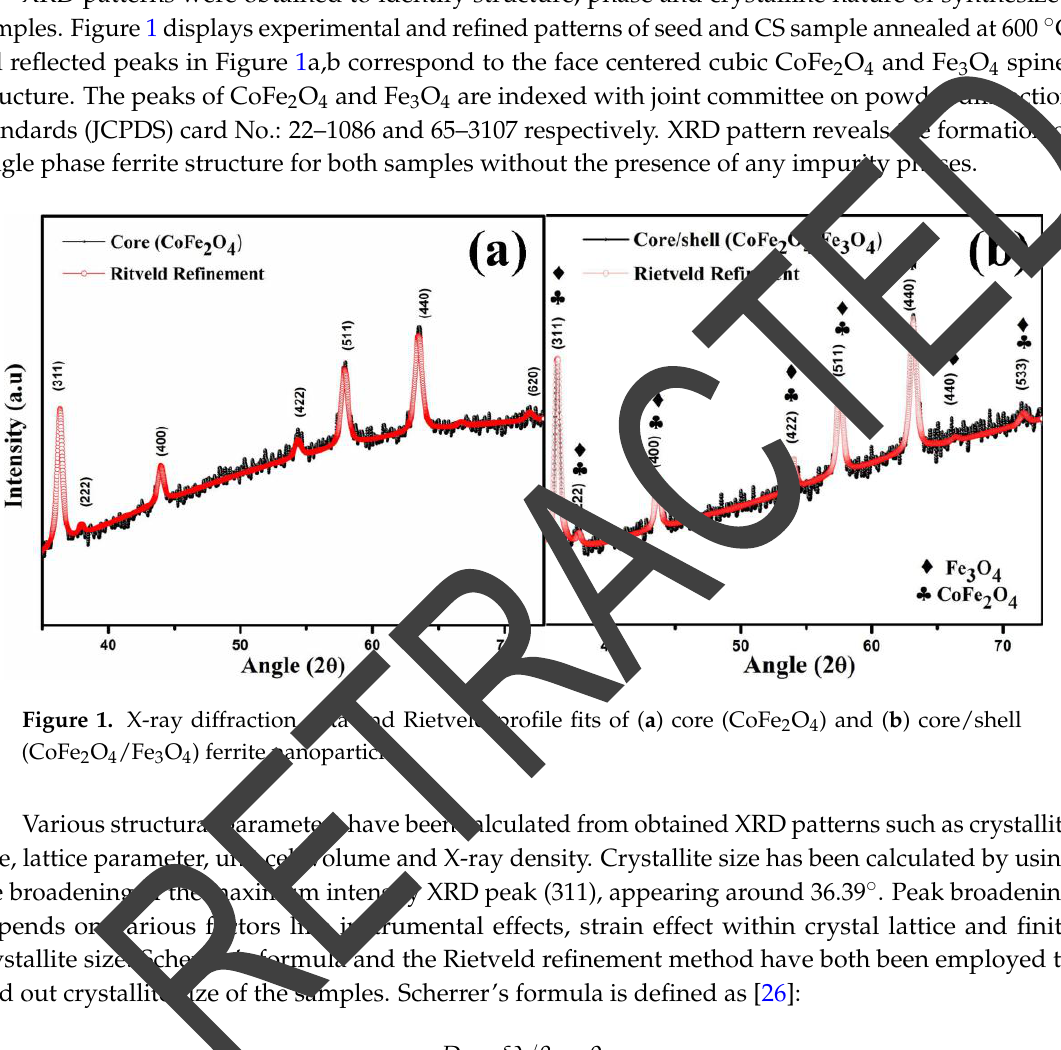
Figure 1. X-ray diffraction data and Rietveld profile fits of ( a ) core (CoFe 2 O 4 ) and ( b ) core/shell (CoFe 2 O 4 /Fe 3 O 4 ) ferrite nanoparticles.